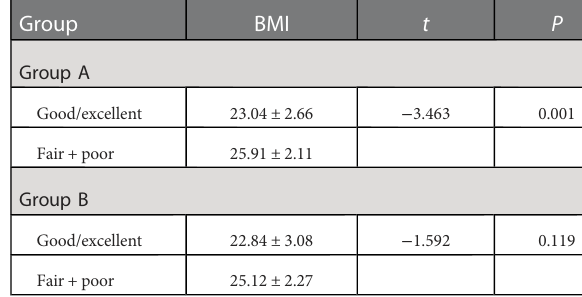
TABLE 3 Male-to-female ratio of patients with good/excellent joint function aged ≤ 30 and >30 years. M F Sum